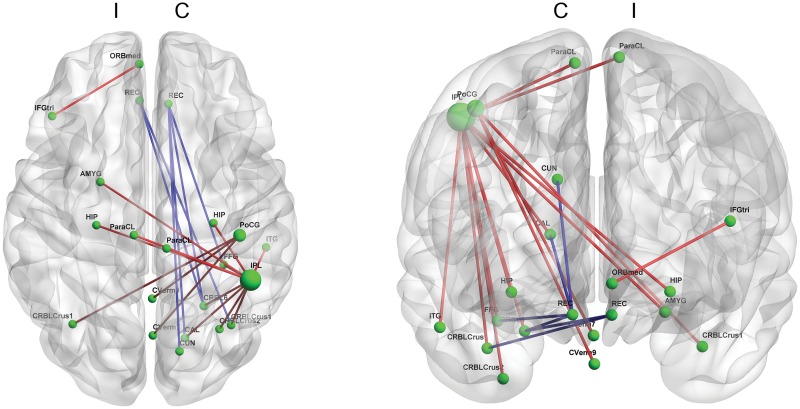
Functional connectivity correlated with the MDS-UPDRS part III score.The inferior parietal area in the contralateral hemisphere has substantial functional connectivity positively correlated with the severity of motor symptoms. The contralateral postcentral gyrus also exhibits functional connectivity positively correlated with the severity of motor symptoms. Connectivity between the pars triangularis and the orbital part of the medial frontal gyrus is also positively correlated with the MDS-UPDRS part III score, whereas the connectivity of bilateral rectus gyri is negatively correlated with this score. (p<0.001) (Blue line: a functional connectivity negatively correlated with the MDS-UPDRS part III score & red line: a functional connectivity positively correlated with the MDS-UPDRS part III score; C: contralateral hemisphere & I: ipsilateral hemisphere; MDS-UPDRS: Movement Disorder Society-sponsored revision of the Unified Parkinson’s Disease Rating Scale)